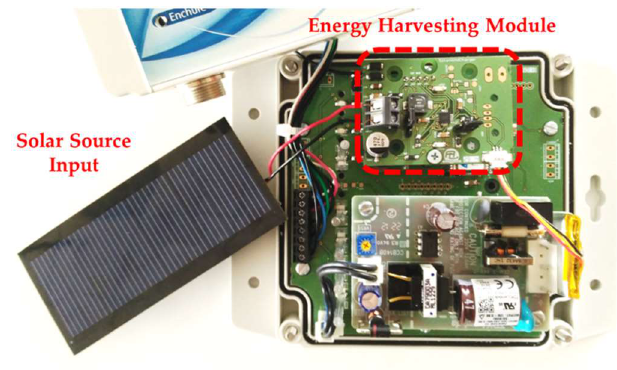
Figure 3. View of the PCB and components of a node with energy harvesting.